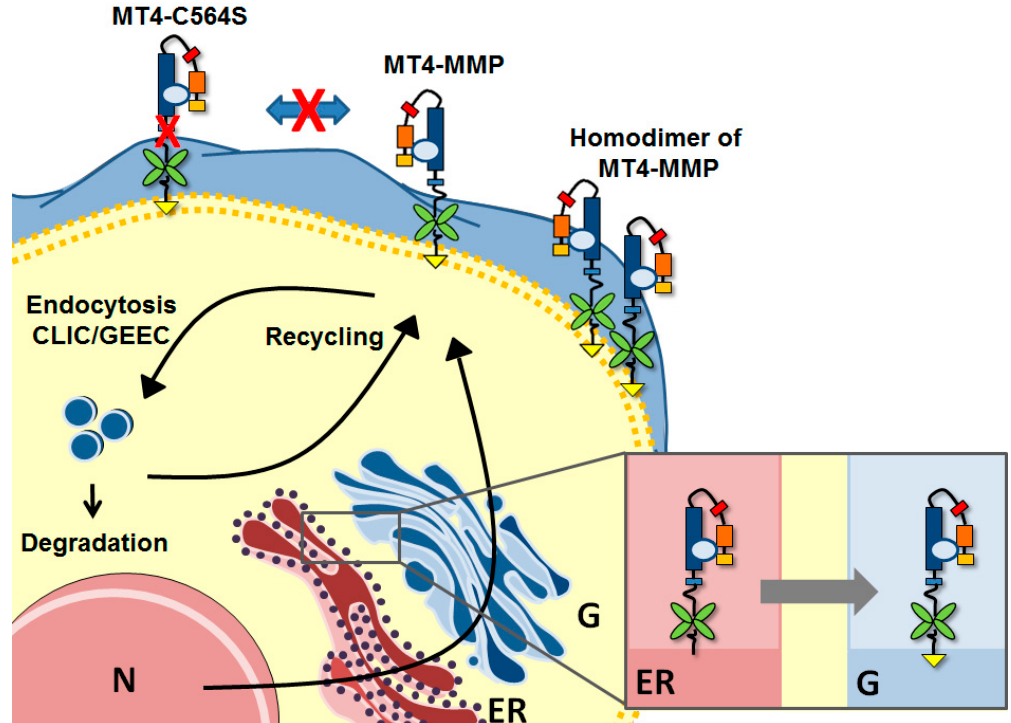
Figure 4. Biosynthesis and trafficking of MT4-MMP. MT4-MMP is associated to the glycosylphosphatidylinositol anchor in the endoplasmic reticulum (ER) and the Golgi (G) before being brought to the membrane. MT4-MMP can form homodimers, but the switch of cysteine with a serine prevents the dimerization. The protease is internalized by the clathrin-independent carriers/GPI-enriched early endosomal compartments pathway (CLIC/GEEC). In the cytoplasm, the protease is degraded or recycled at the membrane. N: